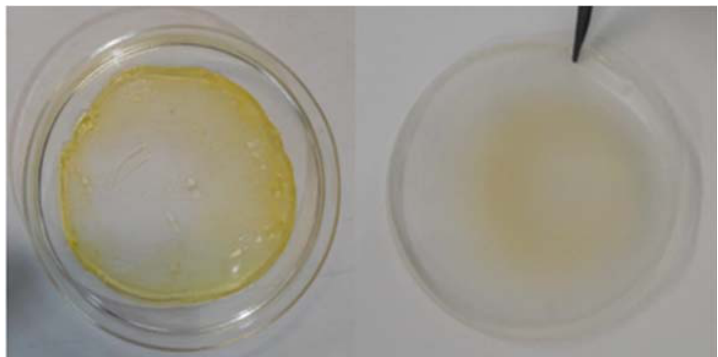
Fig. 2. Photographic appearance of CS/GEL/WGO thin Figure 2 . Photographic appearance of CS/GEL/WGO thin film